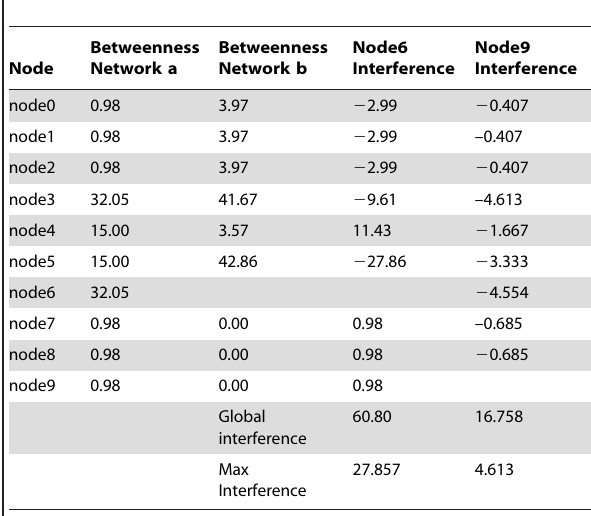
Table 2. Node6 and Node9 interference values of the network in figure 2, expressed as percentage.